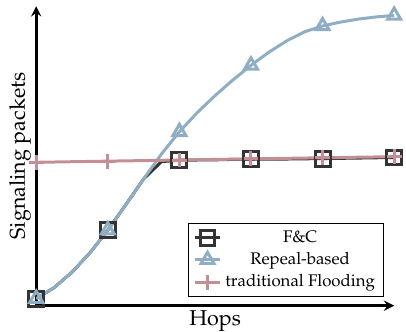
Figure 1. Behavior of Flood and Contain (F&C) vs. other